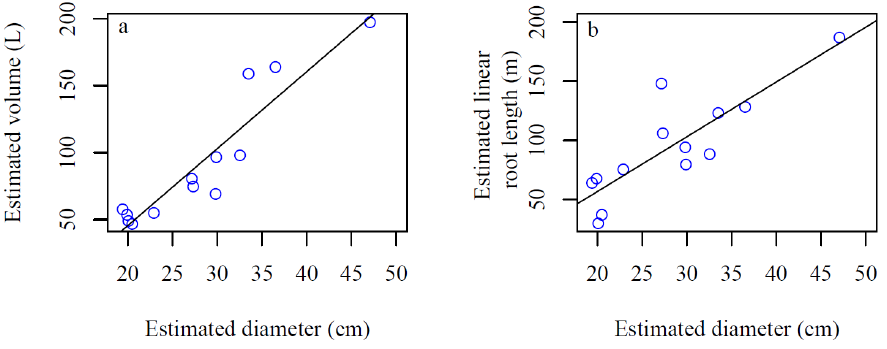
Figure 9. Estimated root system volume and linear root length vs. estimated stump diameter. The lines illustrate fitted regression lines: ( a ) Root system volume = −69.5563 + 5.7511 × estimated diameter; ( b ) Linear root length = −35.6380 + 4.6240 × estimated diameter.